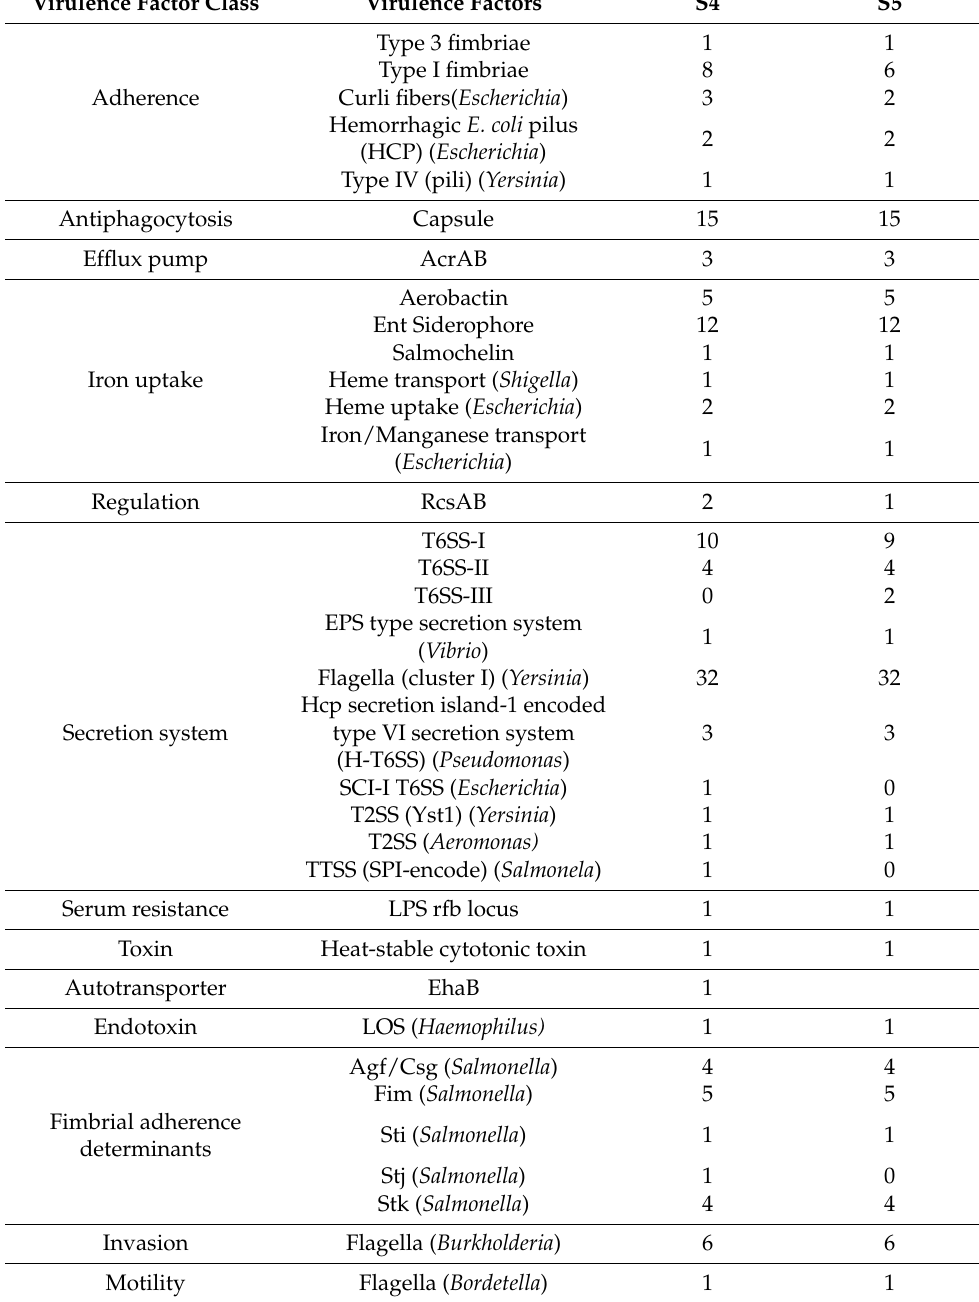
Table 3. Virulence factors detected in the genome sequences of isolates S4 and